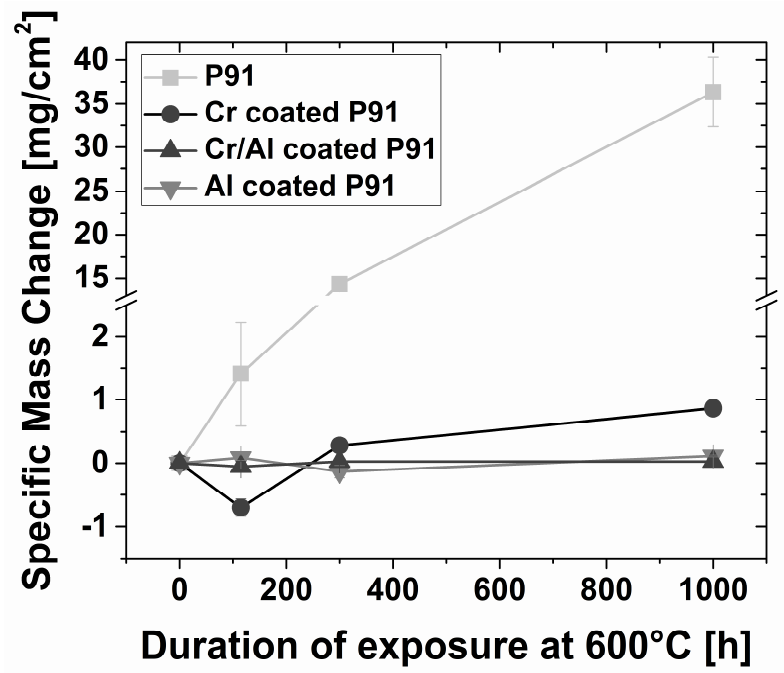
Figure 5. Specific mass change during isothermal exposure in molten solar salt at 600 ◦ C. Please note the y -axis